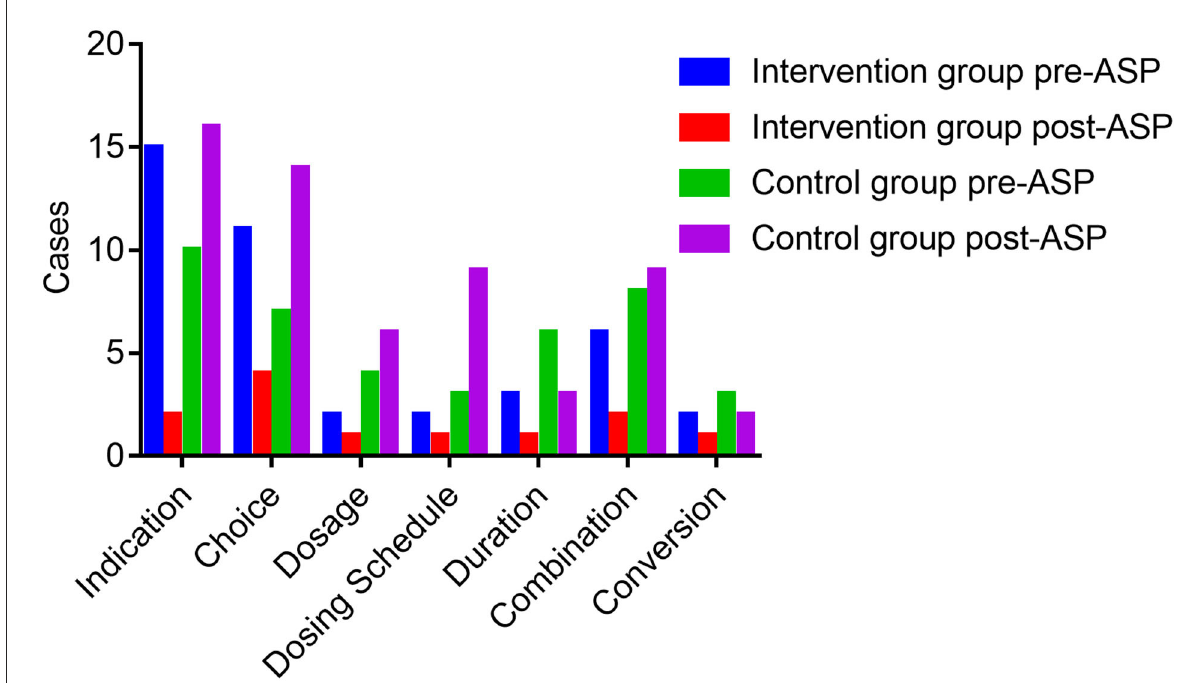
FIGURE2 Inappropriate use of antibiotics before and after the ASPs implementation in the respiratory ward. ASPs, antimicrobial stewardship